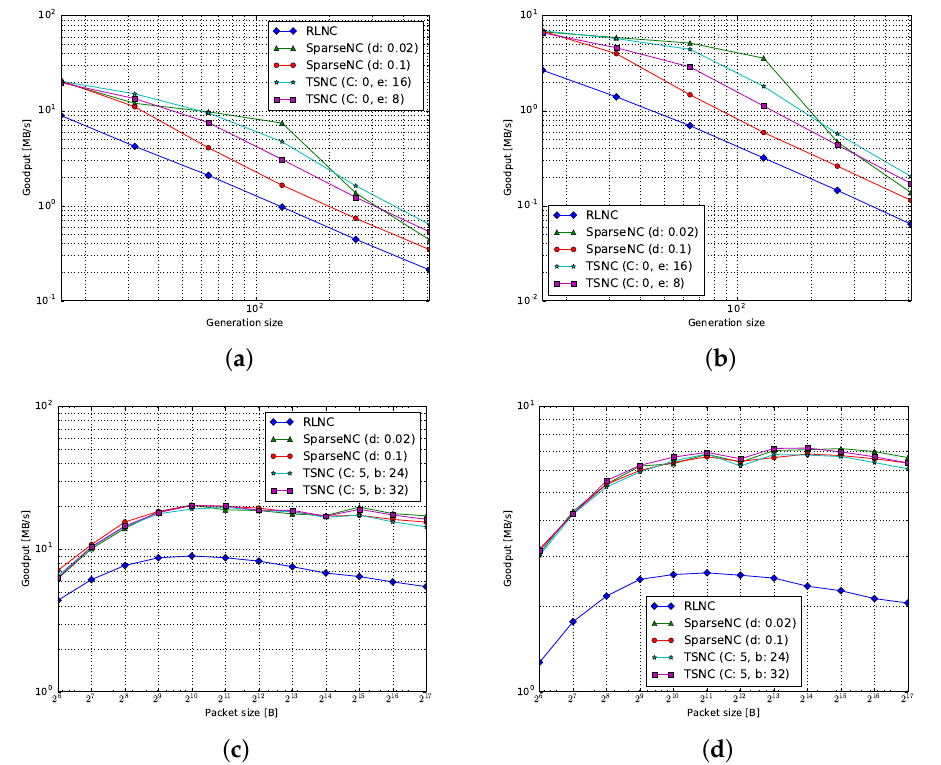
Figure 6. Decoder goodput measurements for the Raspi 1. ( a ) Goodput vs. generation size for q = 2; ( b ) goodput vs. generation size for q = 2 8 ; ( c ) goodput vs. packet size for q = 2, g = 16; ( d ) goodput vs. packet size for q = 2 8 , g = 16.